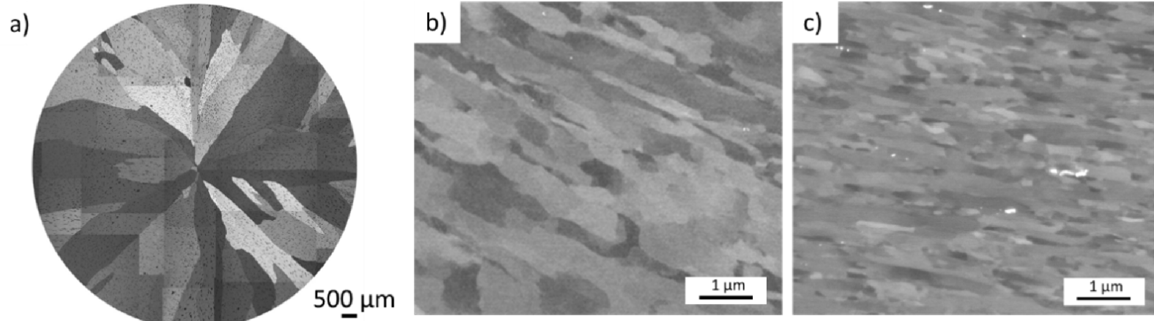
Figure 3. The grain structure ( a ) in the center of the initial bar (LM), and that of samples processed with ( b ) stationary, and ( c ) rotating mandrel on the PD plane, SEM-BSE. The orientation image maps (OIMs) taken from 3 perpendicular directions, ND, RD, and PD, for the sample processed with stationary mandrel are presented in Figure 4.